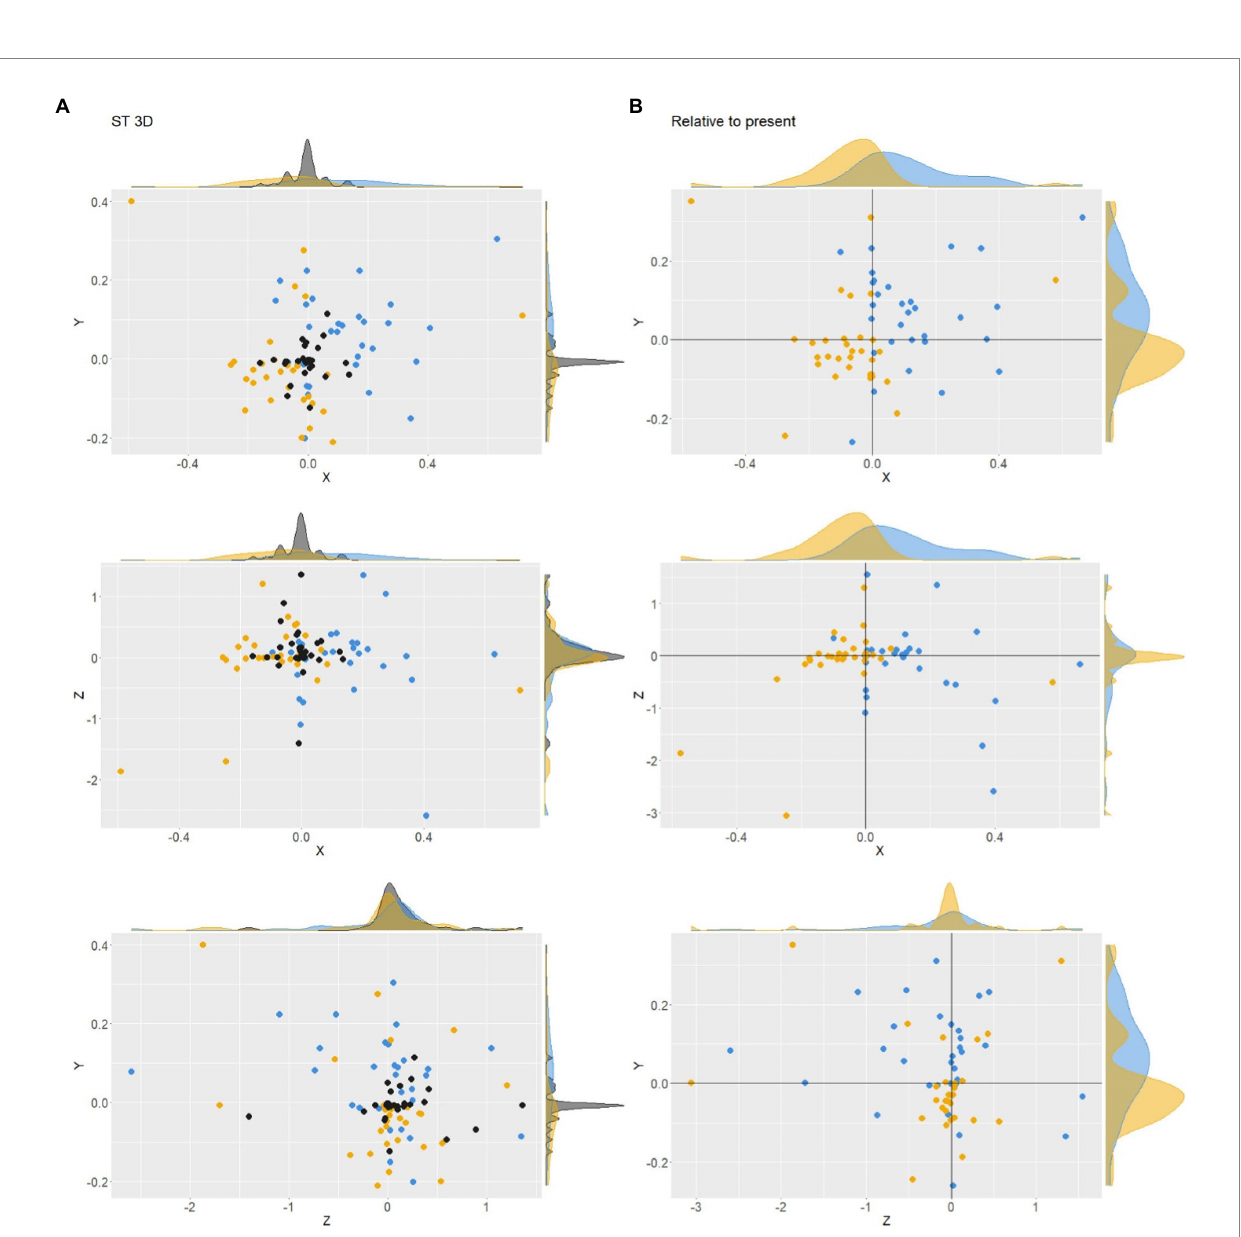
FIGURE 5 Absolute (A) and relative (B) positions in ST in the 3D space. Each yellow, black, and blue dot expresses the past, present, or future position of a participant.